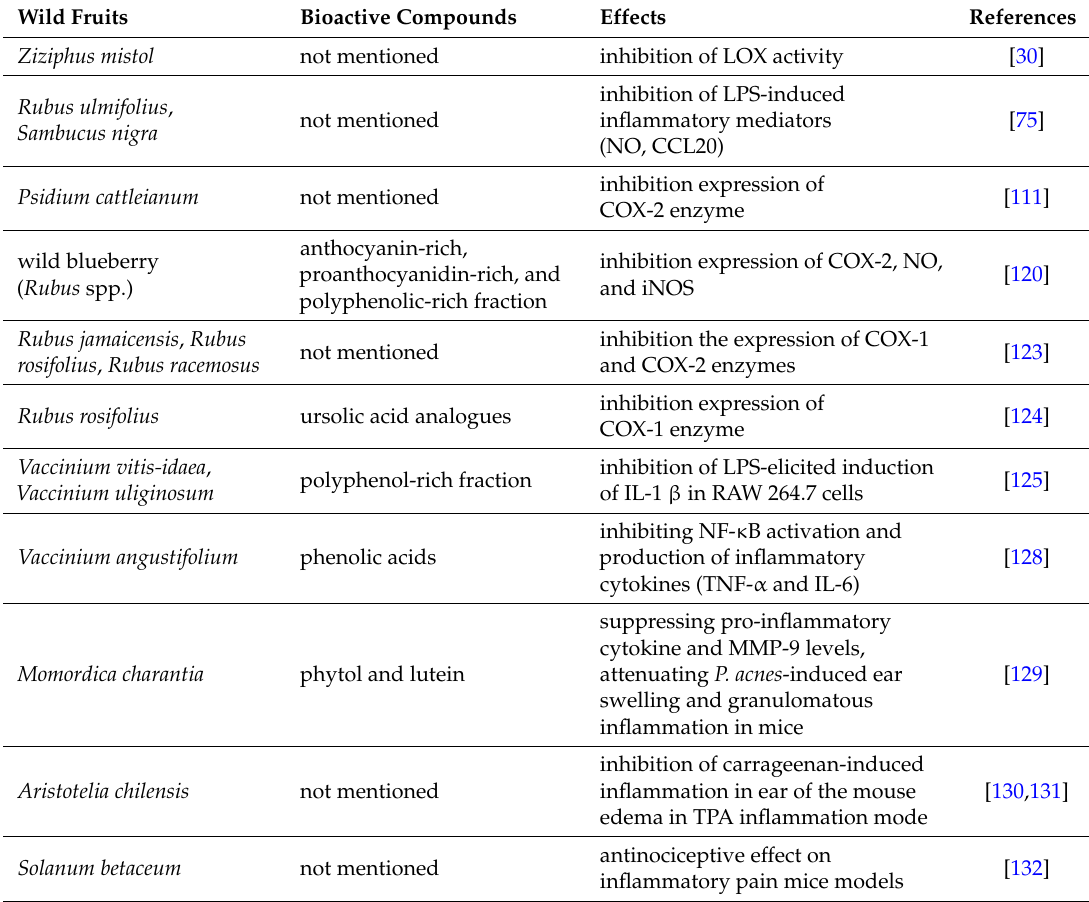
Table 3. Anti-inflammatory activities of some wild